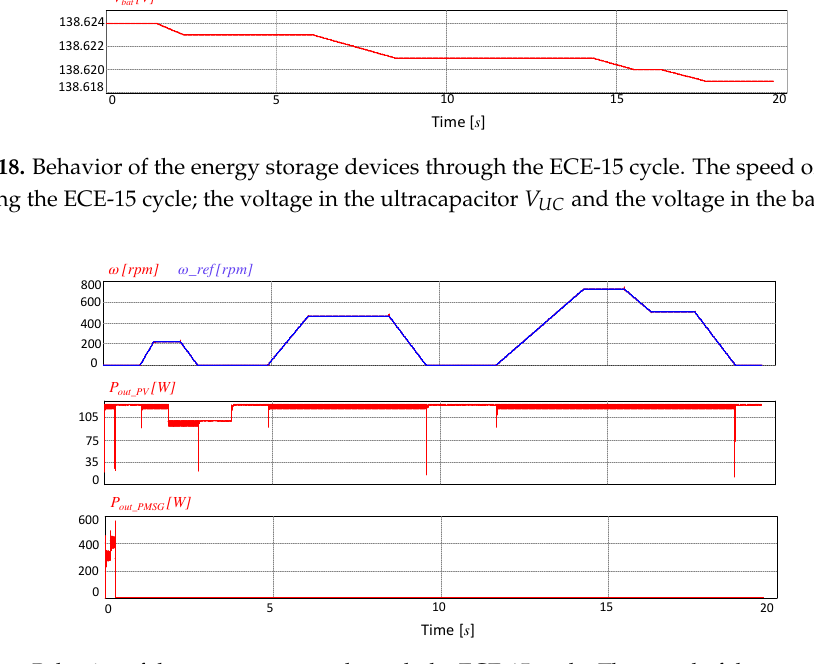
Figure 19. Behavior of the energy sources through the ECE-15 cycle. The speed of the motor following the ECE-15 cycle; the power harvested from the solar panel P out _ PV and the power harvested from the PMSG P out _ PMSG .